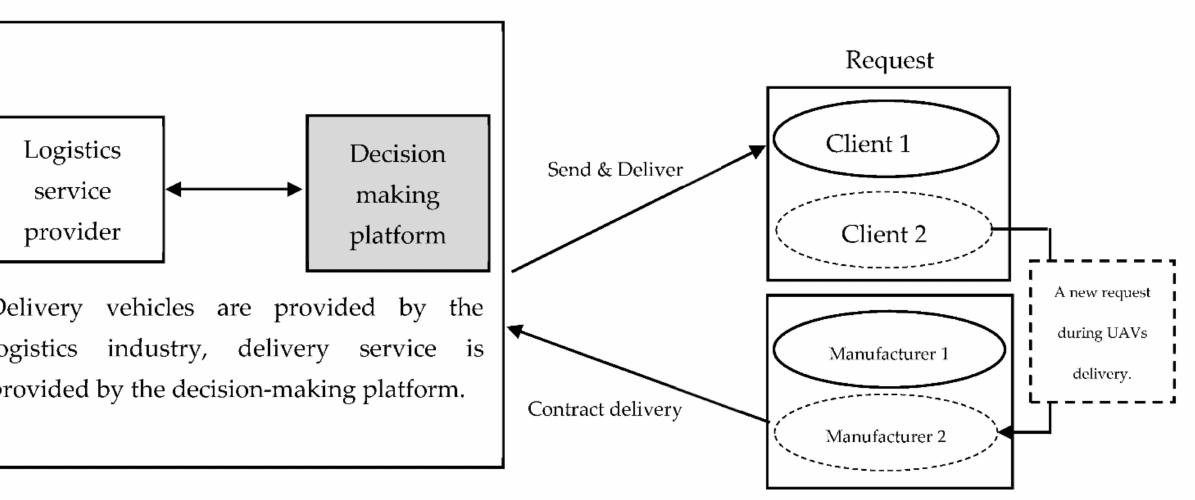
Figure 2. The business model of logistics industry